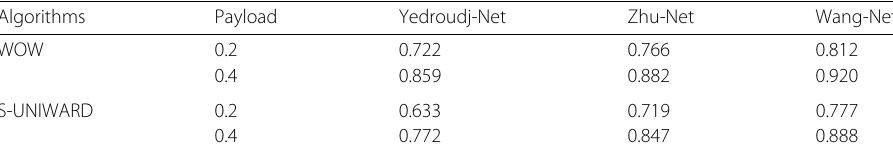
Table 6 The performance of Wang-Net, Yedroudj-Net, and Zhu-Net on resampled images Algorithms Payload Yedroudj-Net Zhu-Net Wang-Net WOW